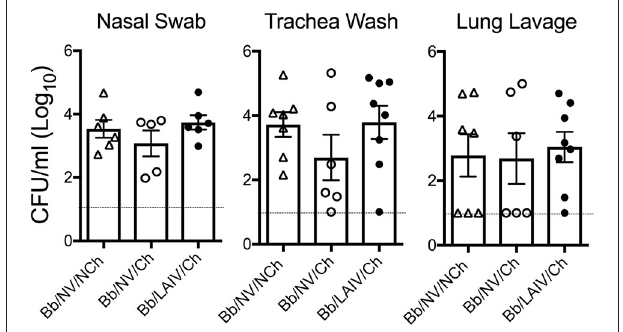
FIGURE 4 | B. bronchiseptica respiratory tract colonization was not affected by IAV challenge, regardless of LAIV vaccine status. Groups of pigs were inoculated with B. bronchiseptica (Bb) on day − 7, LAIV on days 0 and 21, and subsequently challenged (Ch) with heterologous IAV as described in materials and methods. At 5 days post-infection, nasal swab, trachea wash and lung lavage were collected from each pig at necropsy and Bb enumerated to determine if IAV effected Bb colonization in the respiratory tract. Each dot represents a single animal in that respective treatment group, with the average ± SEM indicated. The dotted line represents the limit of detection. Data was analyzed using a one-way ANOVA with a Tukey’s post-test (GraphPad Prism 6). There were no significant differences between groups ( p >